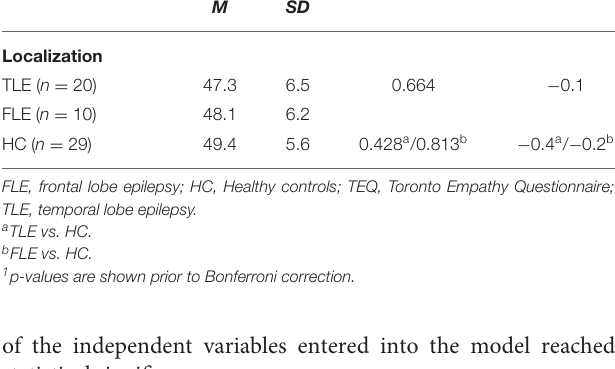
TABLE 5 | Affective empathy according to group status (epileptogenic focus, control group). Patient